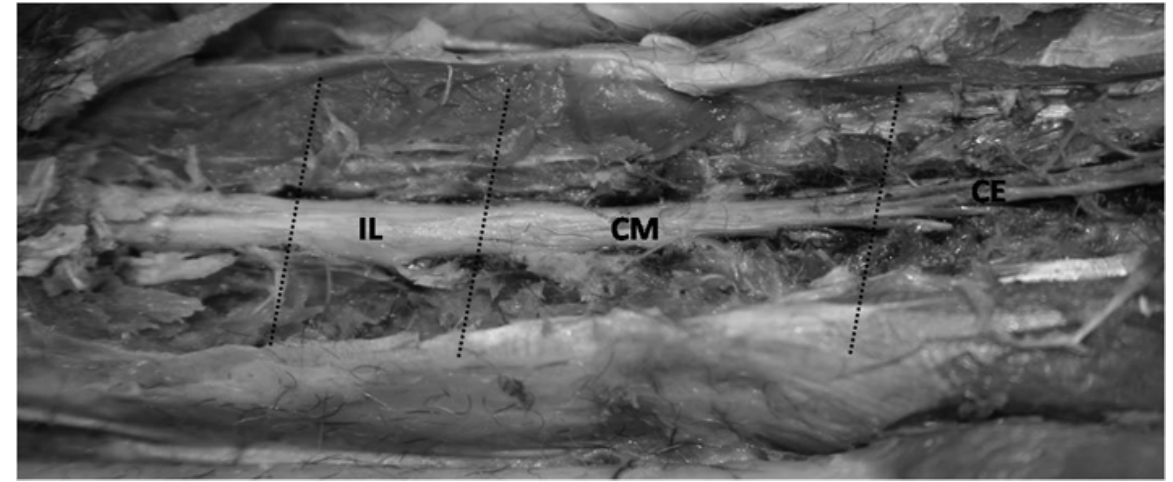
Fig. 2 – Photograph of the dorsal view of the conus medullaris from Saimiri sciureus evidencing lumbar intumescences (IL), conus medullaris (CM) and cauda equine